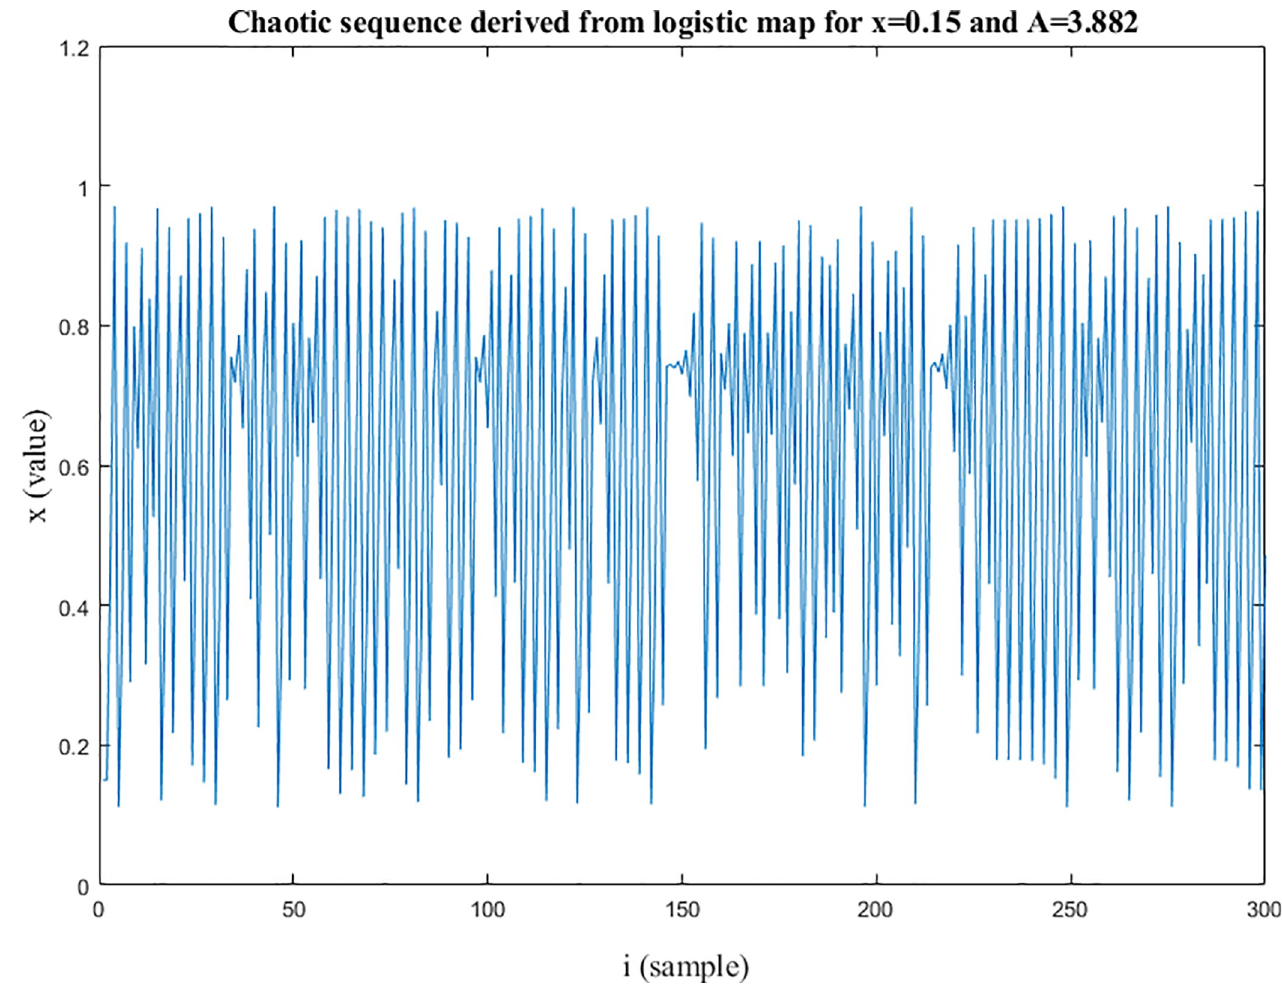
Fig 1. The chaotic sequence. The sequence derived from logistic map for x (0) = 0.15 and A =